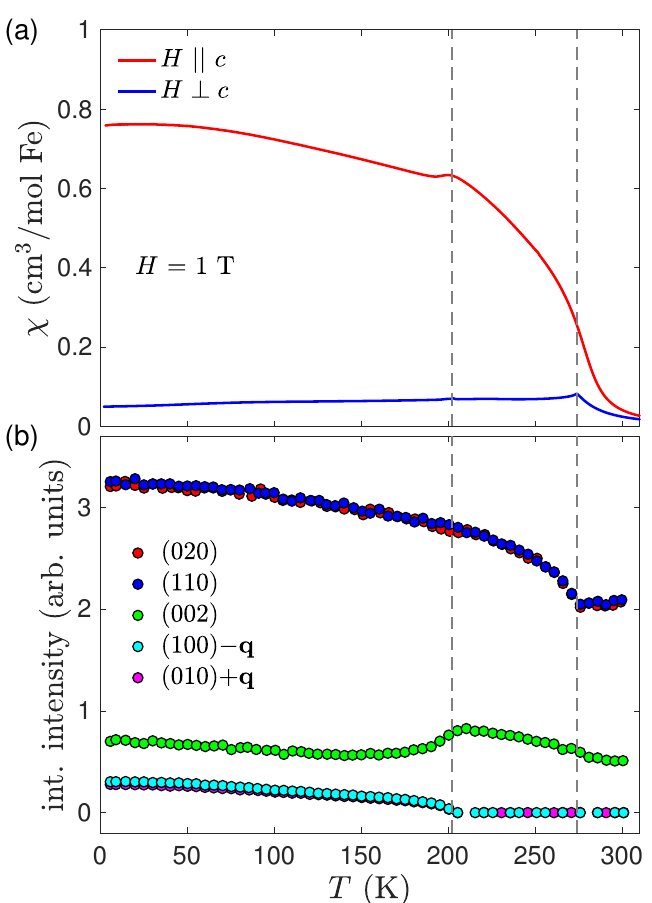
H = 1 T on single 0